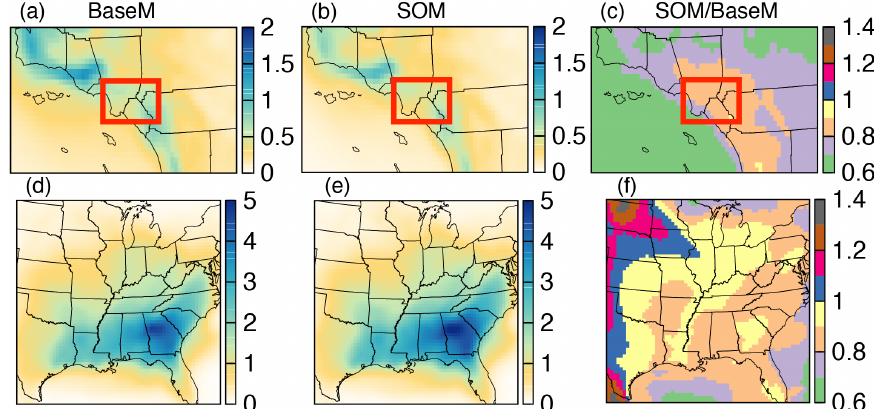
Figure 2. (a, b) 14-day averaged SOA concentrations in SoCAB for the BaseM and SOM simulations. (c) Ratio of the 14-day averaged SOA concentration from the SOM simulation to that from the BaseM simulation. The BaseM and SOM results are averages of the low-yield and high-yield simulations. Red box indicates urban areas surrounding Los